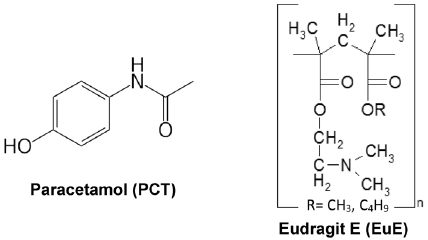
Figure 1. Chemical structures of PCT and